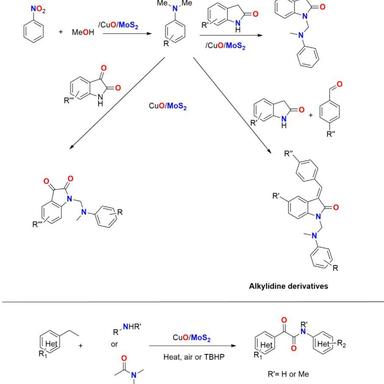
Application of MoS2 based nanocoposites for the synthesis of N-mannish base and a-ketoamides.